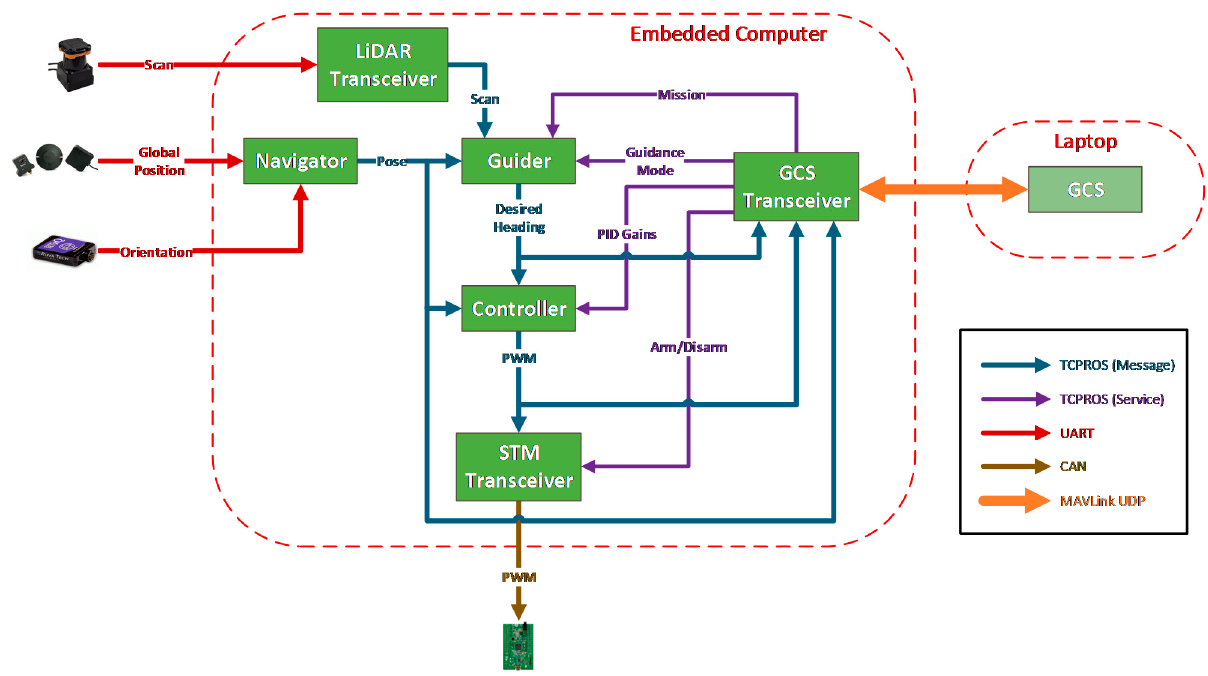
Figure 3. Diagram illustrating connections among different software in VIAM-USV-VC. The vessel’s ground control station (GCS) (Figure 4), namely, VIAM-USV-GC, is a highly customized version of QGroundControl that features two programming layers: QML and C++. QML deals with the front-end part of GCS, offering user-friendly interaction via images, sound, notifications, data visualization, data plotting, etc. On the other hand, C++ makes up the back-end part of GCS, handling computer-intensive tasks such as database management, memory management, device drivers and threading. MAVLink is used to facilitate an efficient, reliable and remote data interchange between ROS-based autopilot and GCS for several advantages: tiny packet’s length (max. 279 bytes); support for detecting packet drops, corruption and packet authentication; cross-platform compatibility.